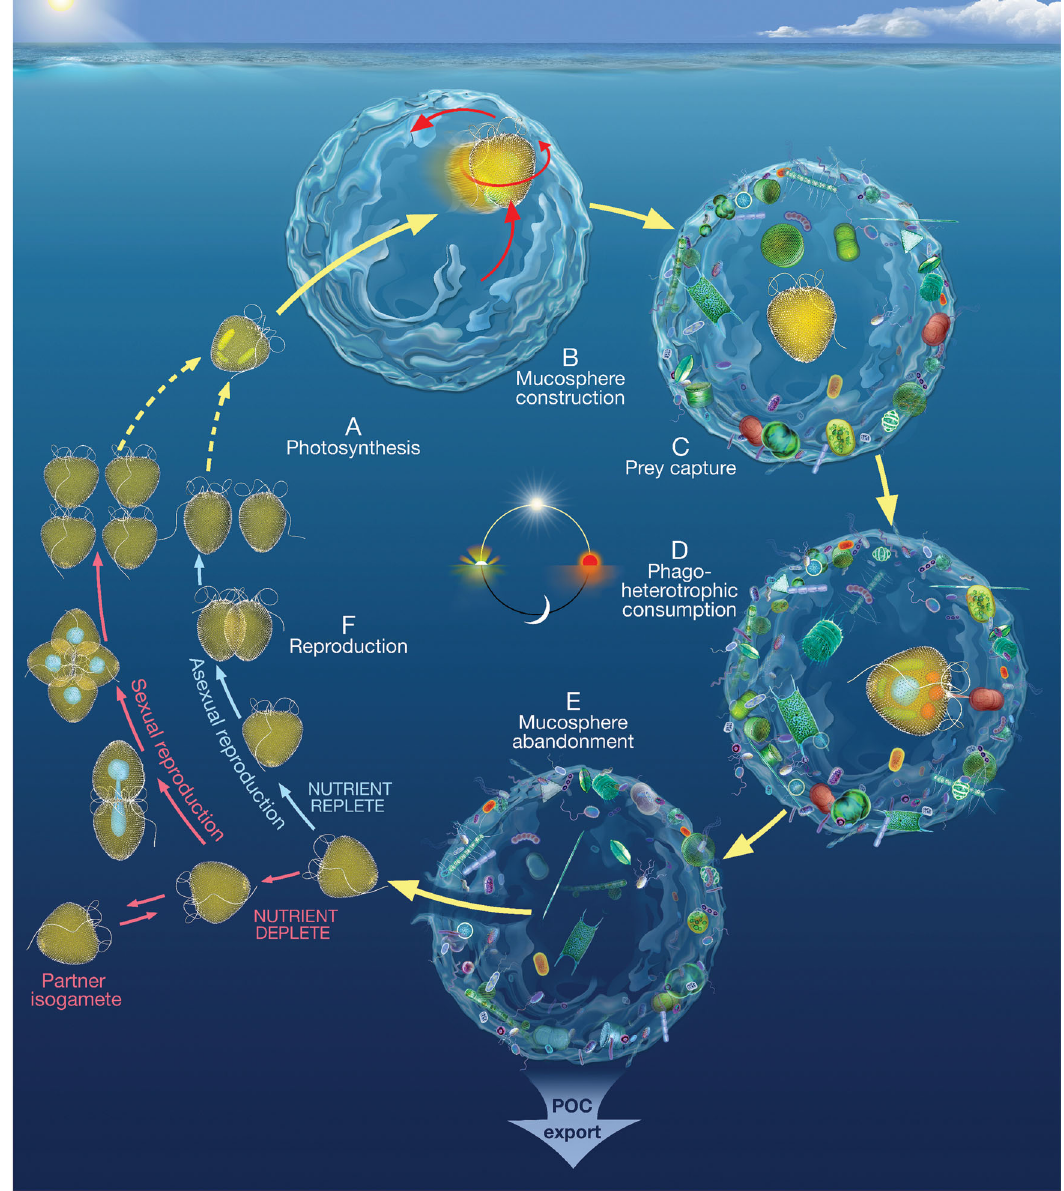
Fig. 4 Summary of Prorocentrum cf. balticum behaviours. An infographic showing the daily cycles of A photosynthesis, B mucosphere production, C prokaryotic and eukaryotic prey attraction and capture, D peduncular phago-heterotrophic feeding, E mucosphere abandonment and carbon export potential, and F asexual or sexual reproduction. The solid yellow arrows represent the daily cycle of the P . cf. balticum cell including entering the mucosphere during construction in ( B ) and exiting the mucosphere in ( E ). The light blue arrows show the P . cf. balticum cell through the asexual reproduction stage and the pink arrows represent the sexual reproduction stage. The broken yellow arrows signify one of the succeeding P . cf. balticum cells from either of the reproduction stages re-entering the daily